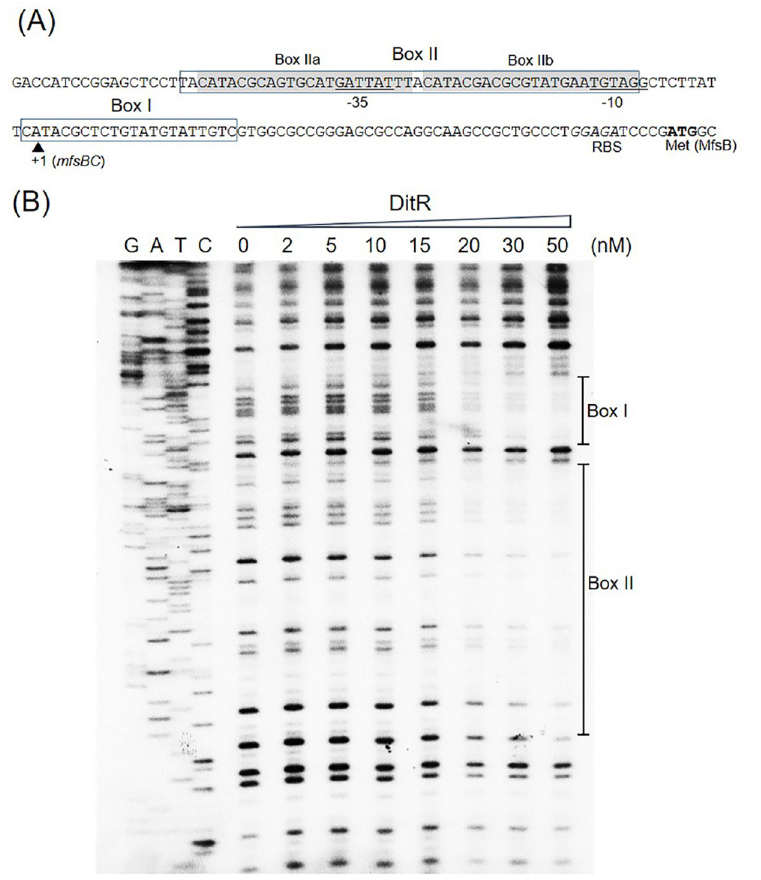
Fig 9. Characterization of the mfsBC promoter and localization of DitR. (A) Putative promoter region of the msfBC operon was characterized. The translation start codon (ATG) and putative ribosome binding site (RBS) are indicated in bold and italic fonts, respectively. Arrowhead indicates putative transcription start site (+1), and the -35 and -10 motifs are underlined. DitR-binding Box I and Box II are boxed, and Box IIa and Box IIb are shaded in gray. (B) DNase I footprinting assay was conducted using increasing concentrations of purified DitR (0–50 nM) and 32 P-labeled 204-bp mfsBC promoter sequence. G, A, T, C is the sequence ladder.